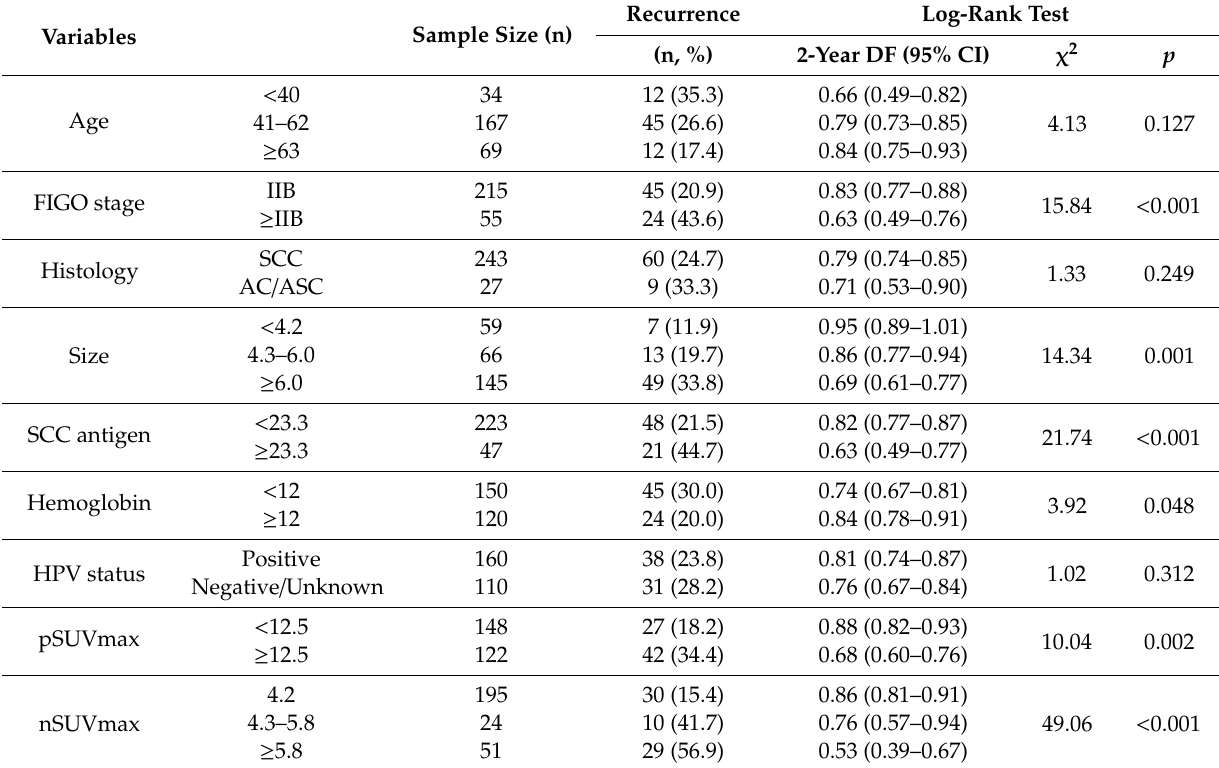
Table 1. Clinicopathologic and [ 18 F]fluorodeoxyglucose PET metabolic parameters of the model derivation cohort for 2-year disease-free